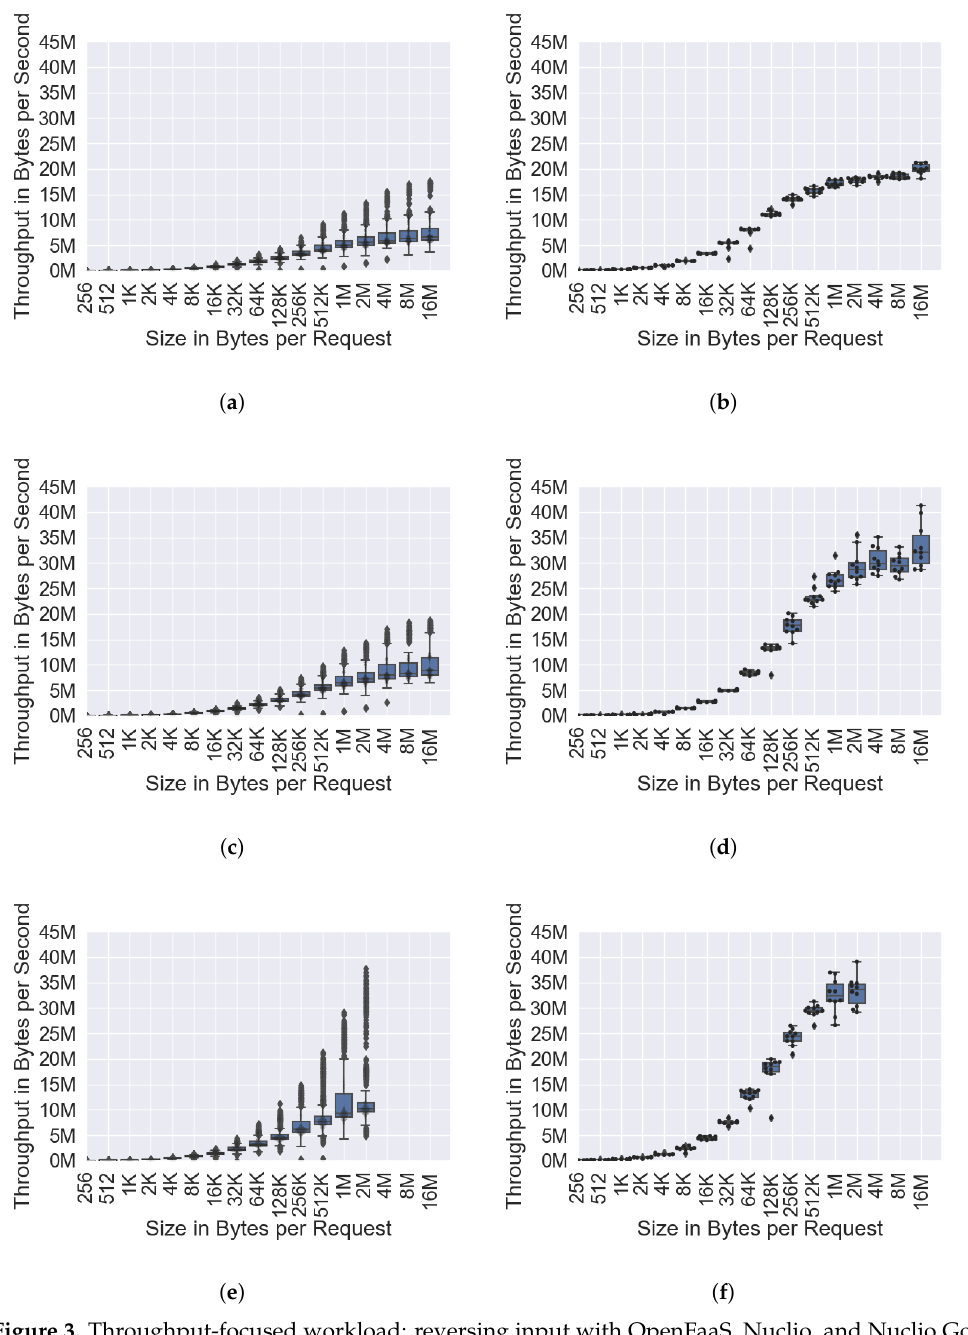
Figure 3. Throughput-focused workload: reversing input with OpenFaaS, Nuclio, and Nuclio